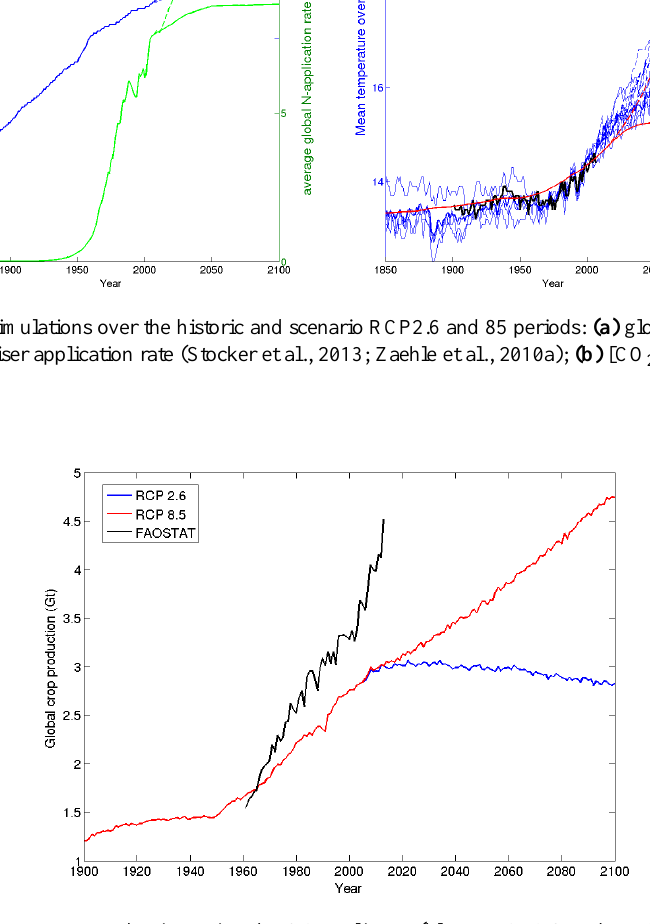
Figure A2. Global simulated mean crop production using the GCM climate (blue – RCP2.6; red – RCP8.5) compared to statistics from FAOSTAT